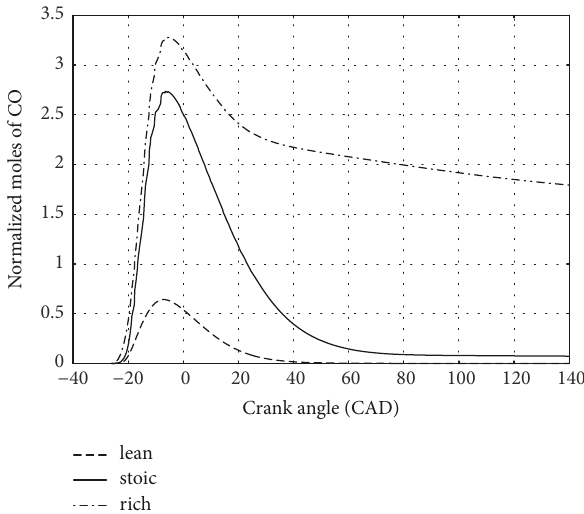
Figure 7: Variation of normalized moles of CO with crank angle.